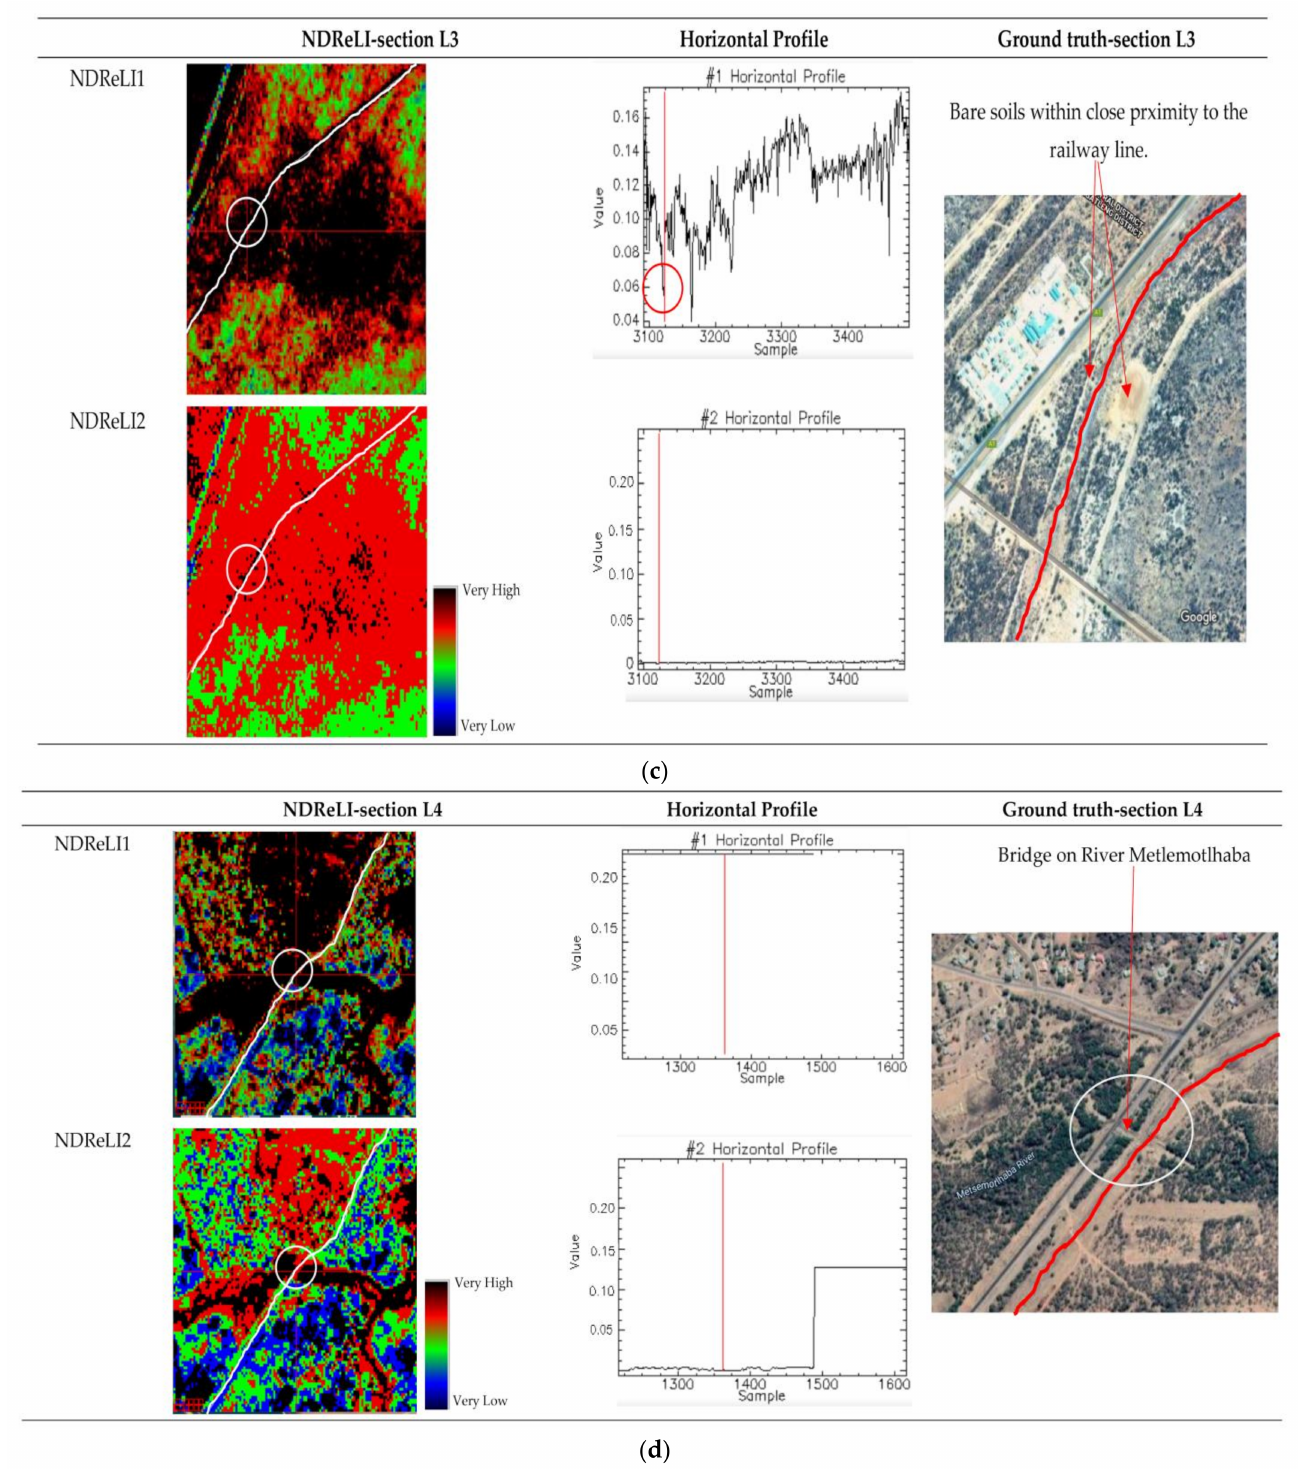
Figure 13. ( a ) Ground truth for section L1. ( b ) Ground truth for section L2. ( c ) Ground truth for section L3. ( d ) Ground truth for section